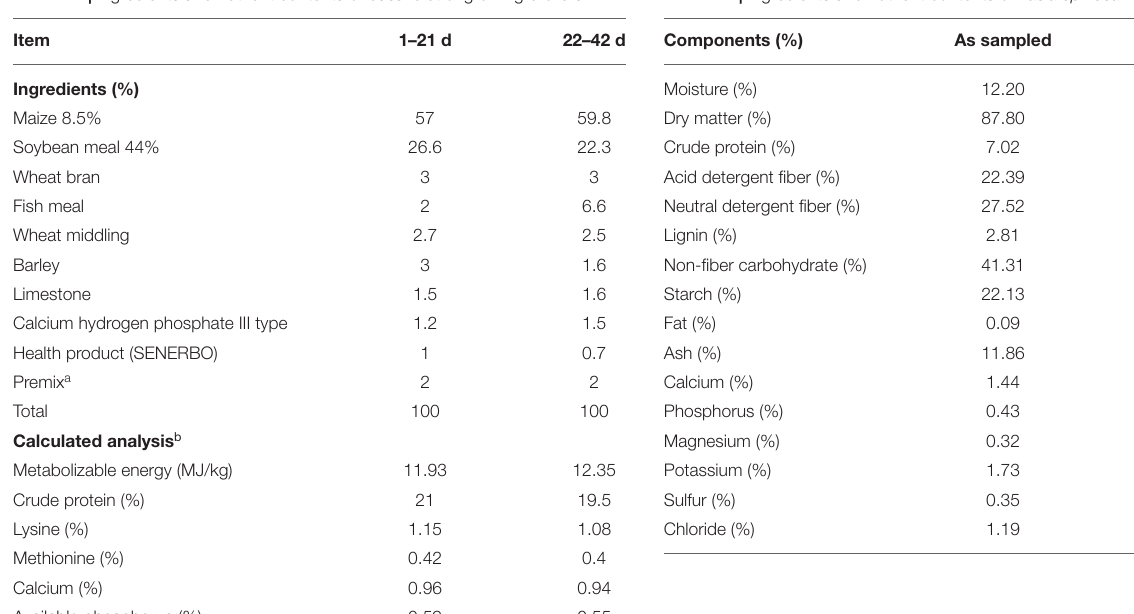
TABLE 1 | Ingredients and nutrient contents of basal diet of growing